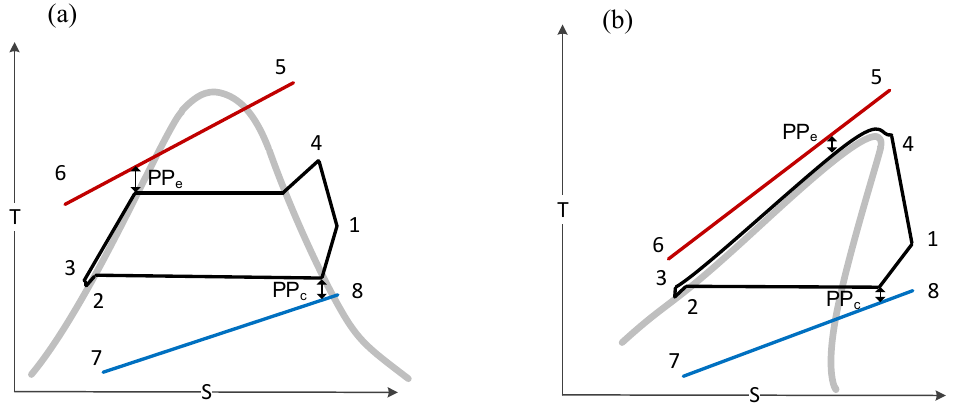
Figure 2. Temperature-entropy (T-s) diagram: ( a ) subcritical ORC and ( b ) transcritical